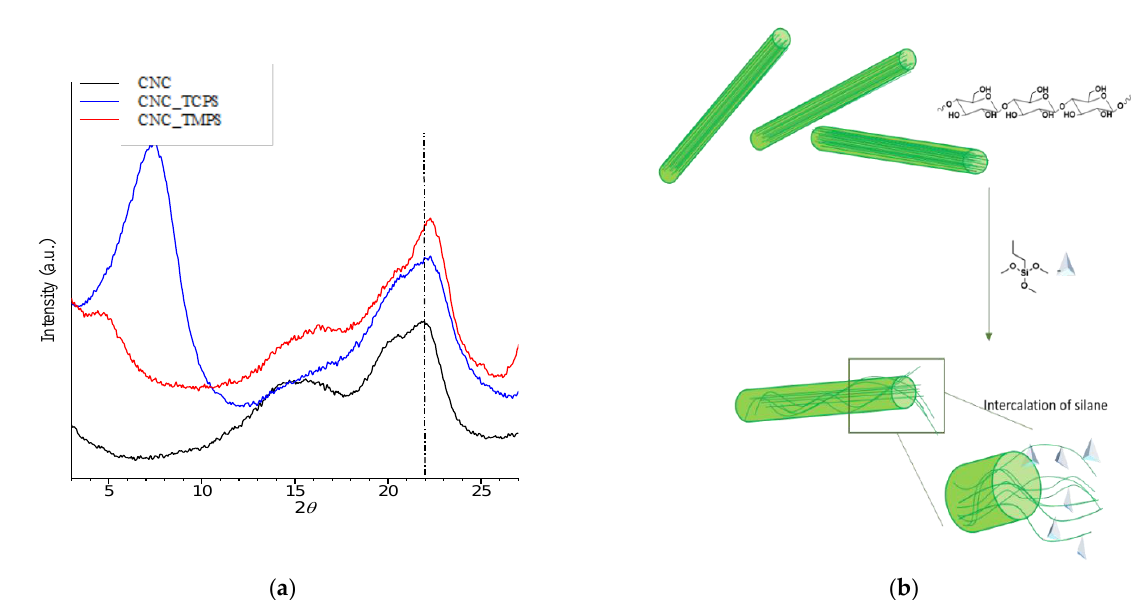
Figure 4. WAXS spectra of CNCs-grafted-TCPS and CNCs-grafted-TMPS ( a ); scheme of silane intercalation ( b ).